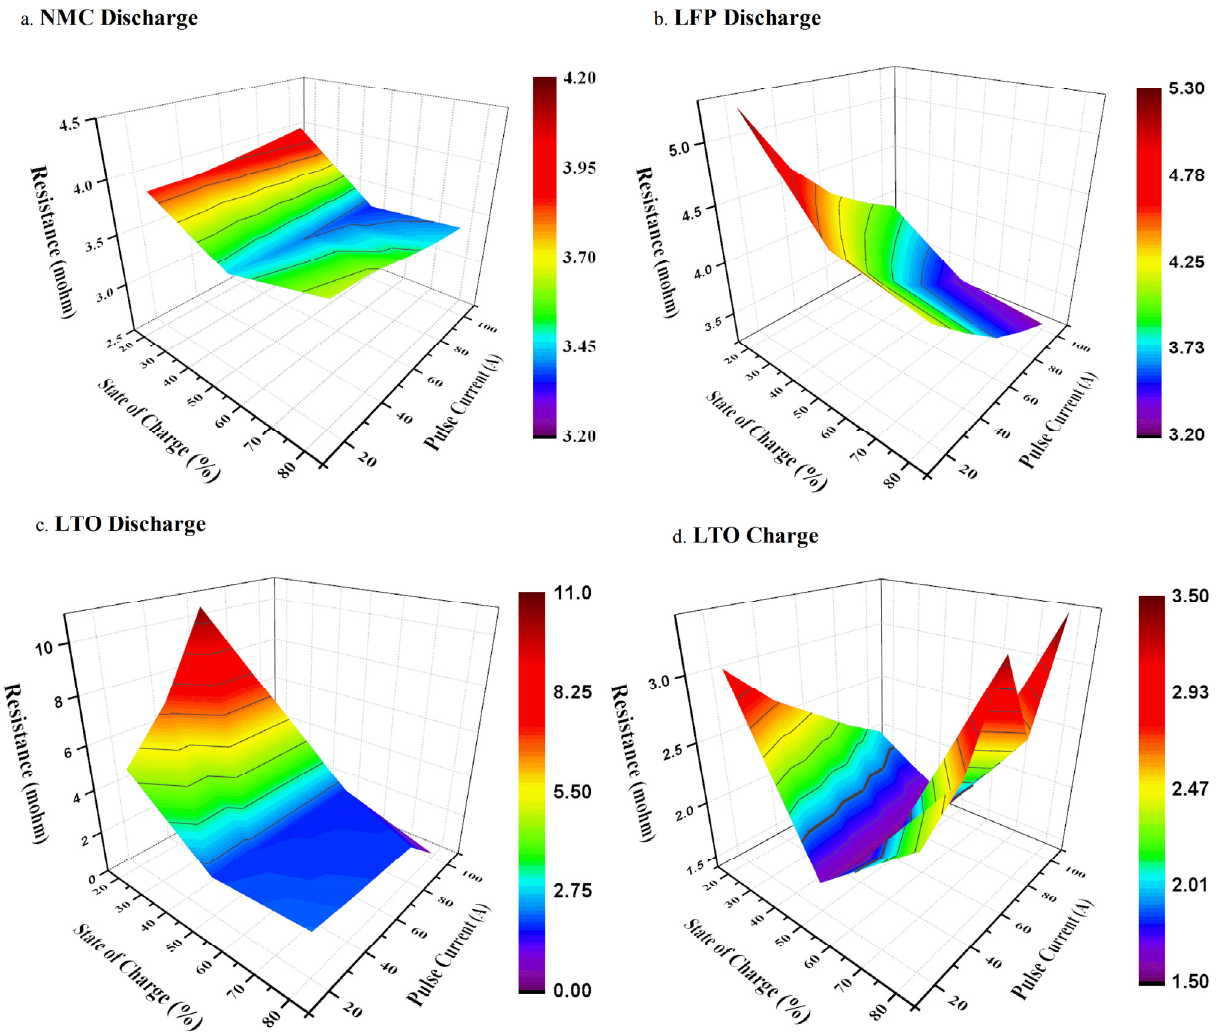
Figure 2. Internal resistances measured by HPPC test at an 80%, 50% and 20% SoC level with pulse currents of 20, 40, 60, 80, 100 A of ( a ) NMC discharge pulses; ( b ) LFP discharge pulses; ( c ) LTO discharge pulses; ( d ) LTO charge